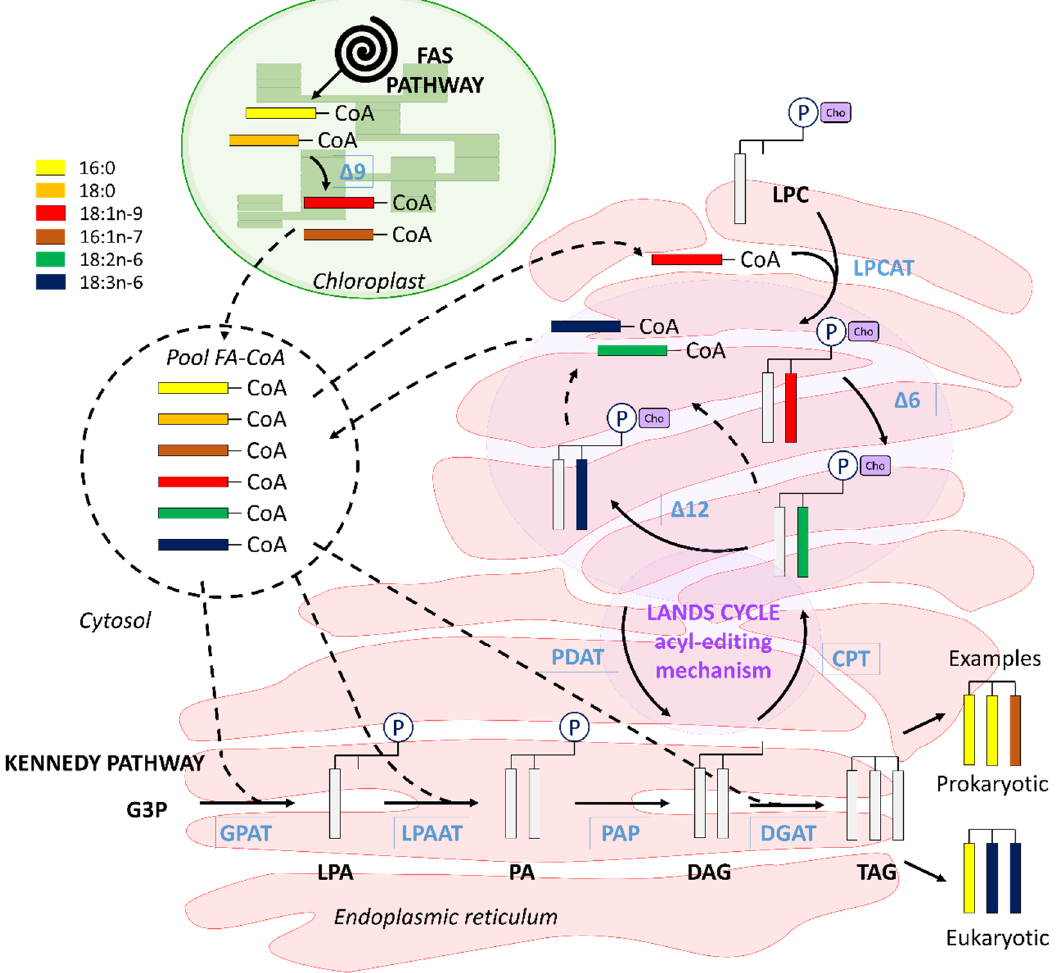
Figure 12. Hypothesized synthesis of phosphatidylcholine (PC) and triacylglycerol (TAG) in C. muelleri . CoA: co-enzyme A, CPT: cytidine-5′-diphosphate choline phosphotransferase, DAG: diacylglycerol, DGAT: acyl-CoA DAG acyltransferase, G3P: glycerol-3-phosphate, GPAT: acyl-CoA-